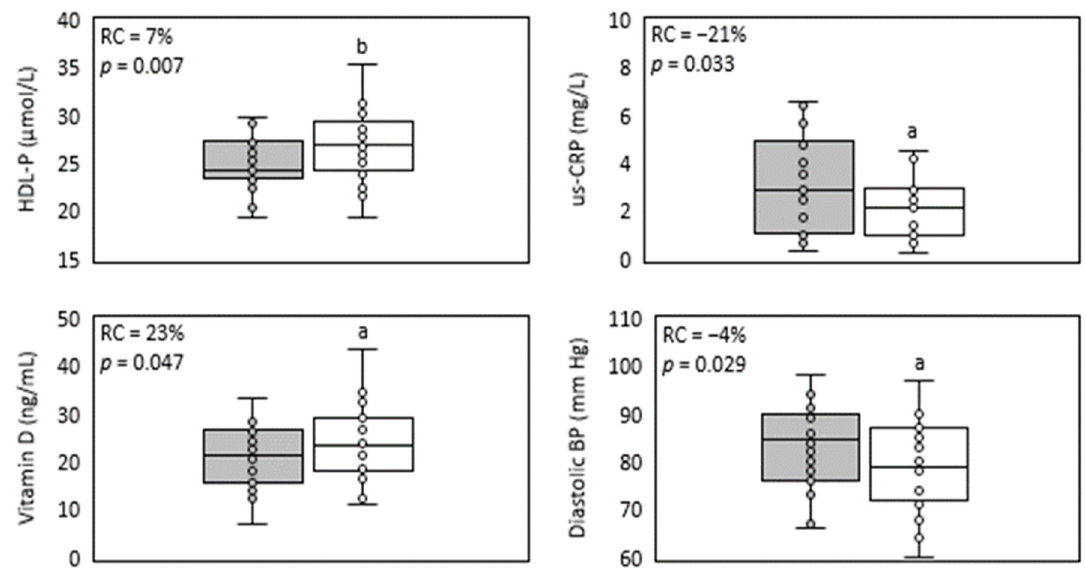
Figure 1. Main parameters improved in NAFLD by treatment with sub-micron phytosterols. Box and whisker plots of liver fat, plasma triglycerides, medium VLDL-particles, HDL-C, HDL-particles, us-CRP, vitamin D and diastolic blood pressure. The baseline values’ distribution is represented in the grey box, and the end values’ distribution is represented in the white box. The relative change median (RC) and p -value ( p ) are shown inside each plot. n = 26, except for lipids, lipoproteins and us-CRP ( n = 25). a = p < 0.05 and b = p < 0.01 according to Wilcoxon test.